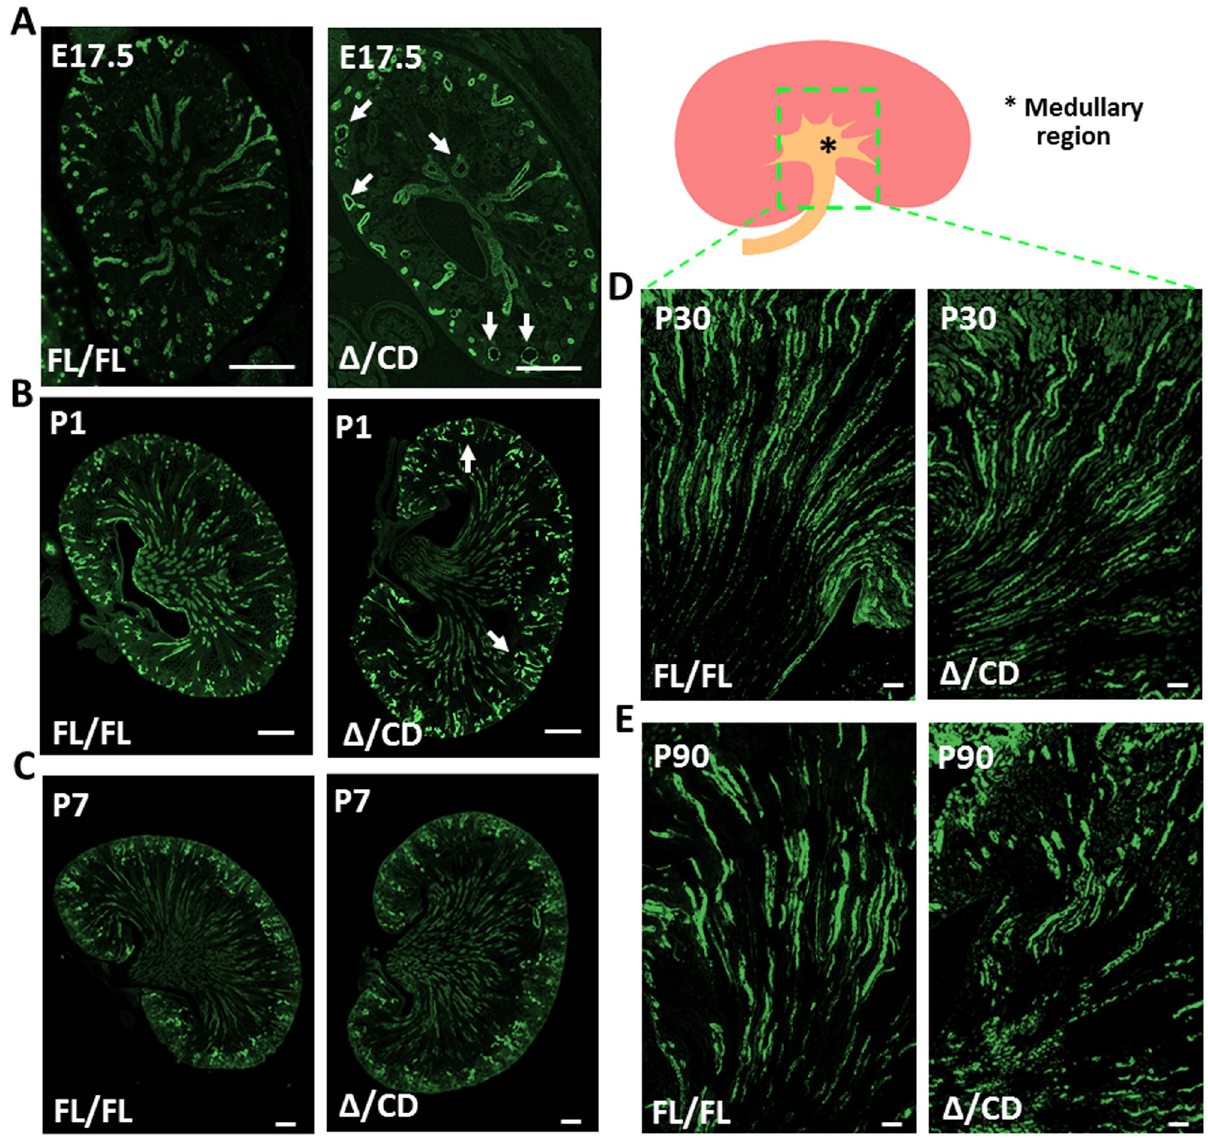
Fig 4. Morphology of collecting duct tubules in conditional Hoxb7-Cre; Vangl2 Δ /CD mice. (A) E17.5 Vangl2 Fl/Fl (control) and Vangl2 Δ /CD (mutant) kidneys stained with DBA (collecting duct marker, green); dilated tubules are indicated by arrows. Scale bars, 100 μ m. (B) Postnatal day 1 (P1) Vangl2 Fl/ Fl and Vangl2 Δ /CD kidneys stained with DBA (green); dilated tubules are indicated by arrows. Scale bars, 100 μ m. (C) P7 Vangl2 Fl/Fl and Vangl2 Δ /CD kidneys stained with DBA (green); Scale bars, 100 μ m. (D) P30 kidney medullary region stained with DBA (green), Scale bars, 100 μ m. (E) P90 kidney medullary region stained with DBA (green), Scale bars, 200 μ